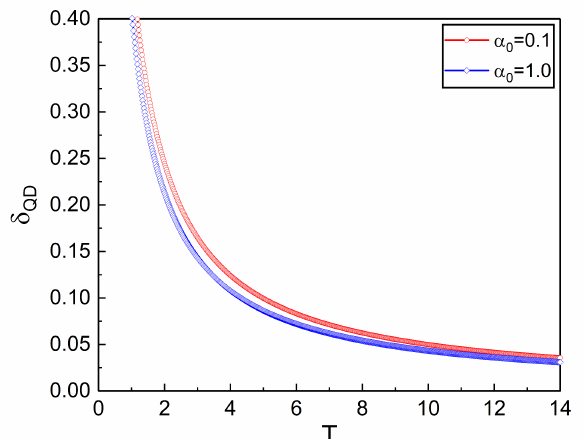
Figure 1. Measure of degree of quantum decoherence for the damped harmonic oscillator (Equation (72)) plotted as a function of T . The values that we adopted in this figure are ¯ h = 1, k = 1, and Ω 0 = 1. These values (and all values taken in the subsequent figures) are dimensionless for